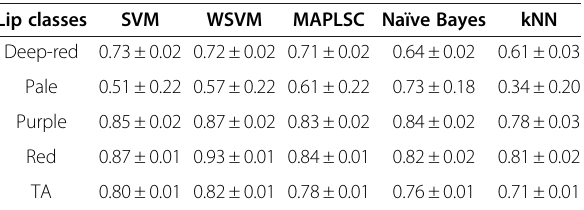
Table 1 Accuracy of lip image classification using SVM, WSVM, kNN,MAPLSC and Naive Bayes on all the 84 features (mean±